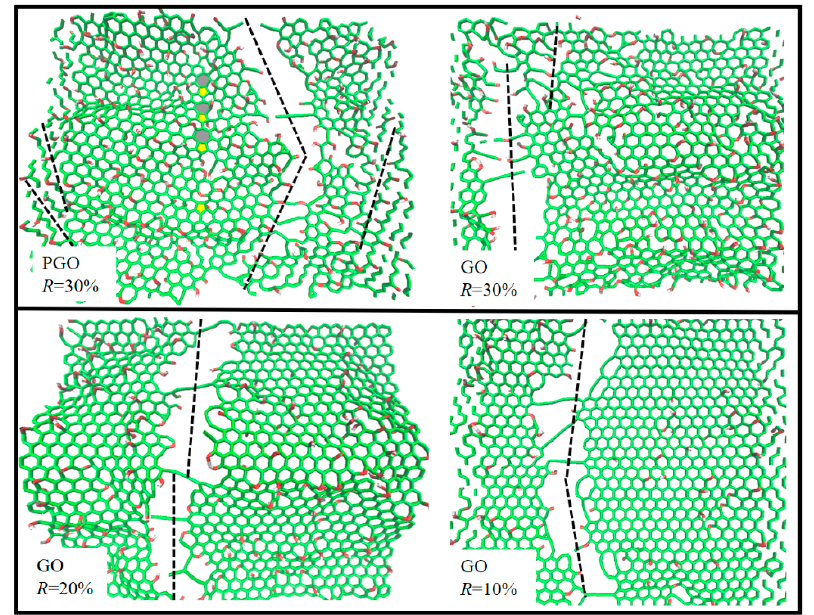
Figure 6. Tensile failure process of polycrystalline graphene oxide and graphene oxide at different R.